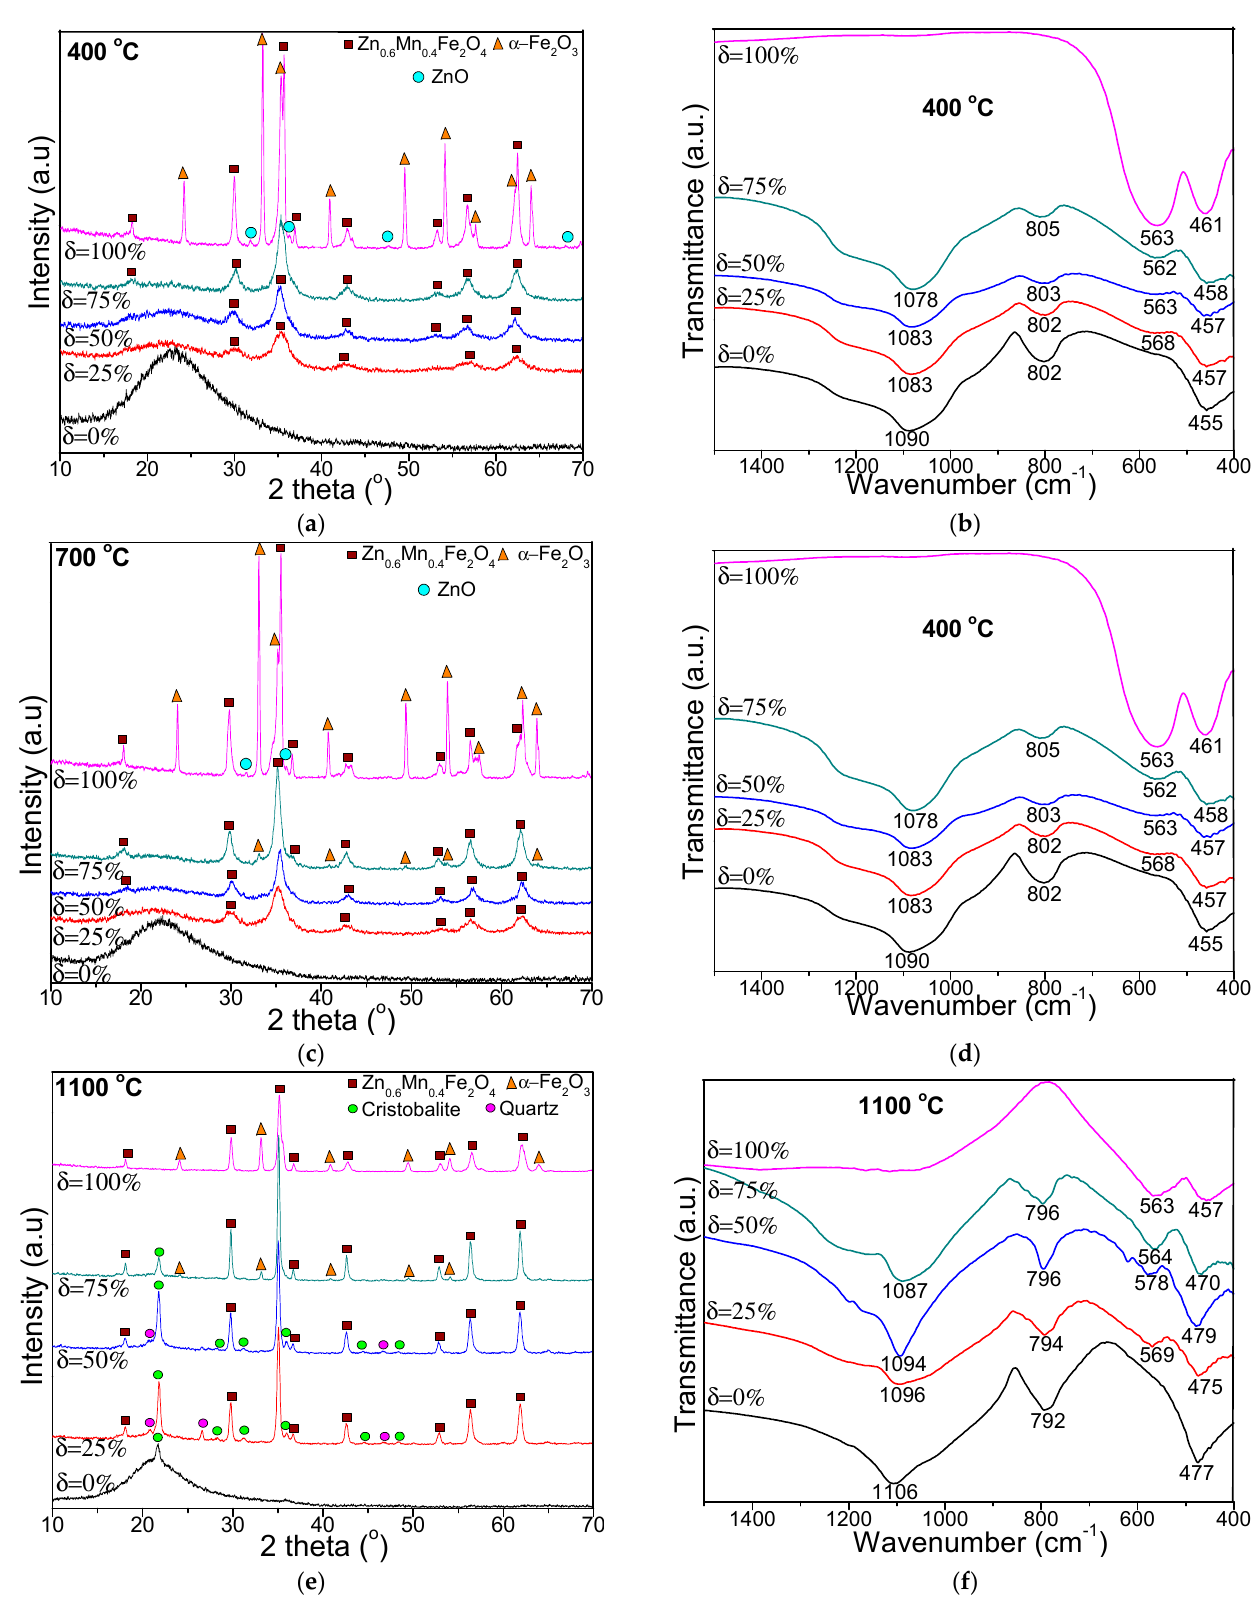
Figure 2. XRD patterns ( a , c , e ) and FT-IR spectra ( b , d , f ) of (Zn 0.6 Mn 0.4 Fe 2 O 4 ) δ (SiO 2 ) 100 −δ NPs calcined at 400, 700 and 1100 °C.